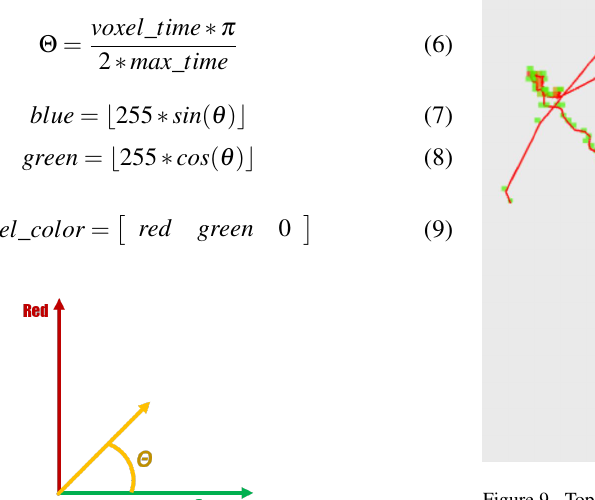
Figure 8. The representation in a two dimensional space of relation between the time spent int that voxel and the maximum time the user spent in all voxels.